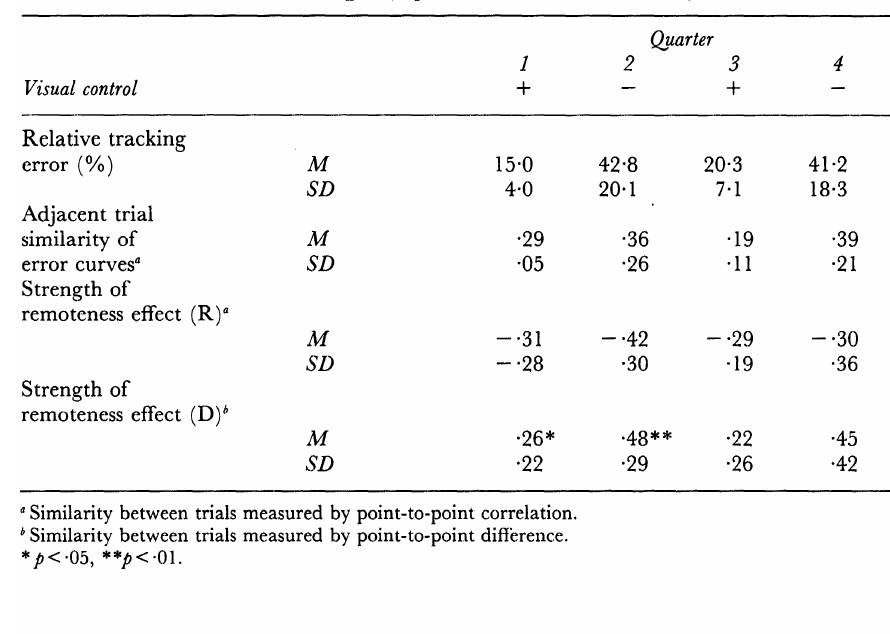
TABLE 3_ Effect of intermittent withdrawal of visual control on tracking error, atfjacent trial similarity, and remoteness effect (experiment 2, mean and SD, n = 8)